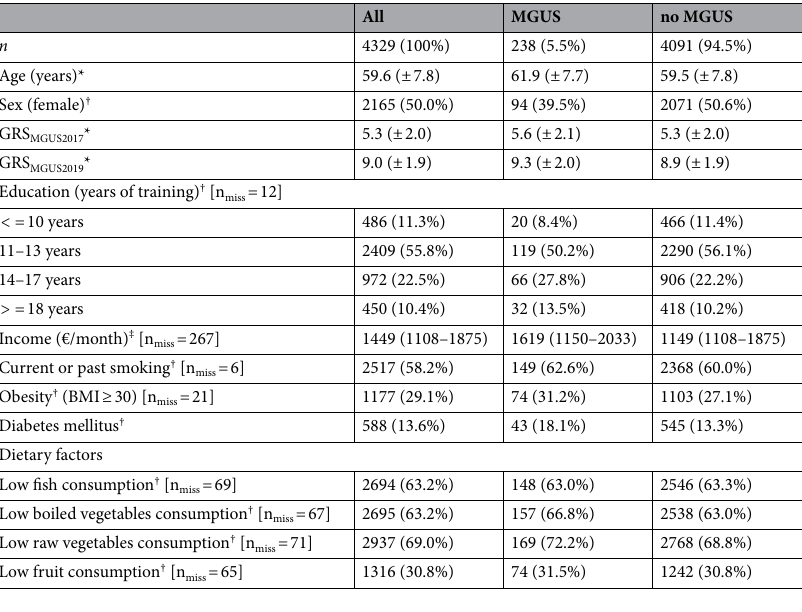
Table 1. Characteristics of the study population stratified by MGUS status. *Mean (± sd), † Number(%), ‡ Median (quartile range).